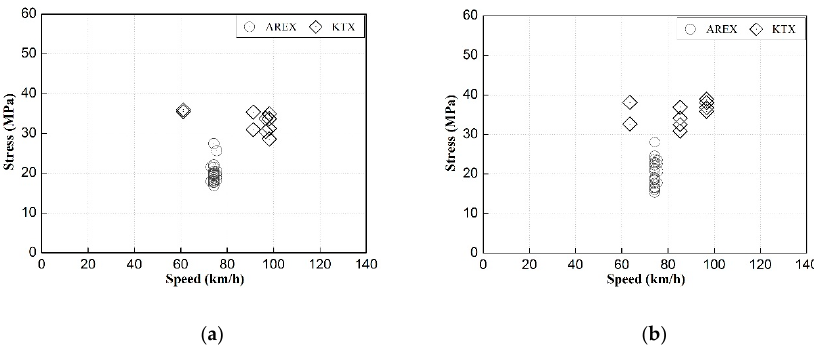
Figure 10. Measured lateral displacement of the rail by train type. (a) Before rail pad replacement and (b) after rail pad replacement.